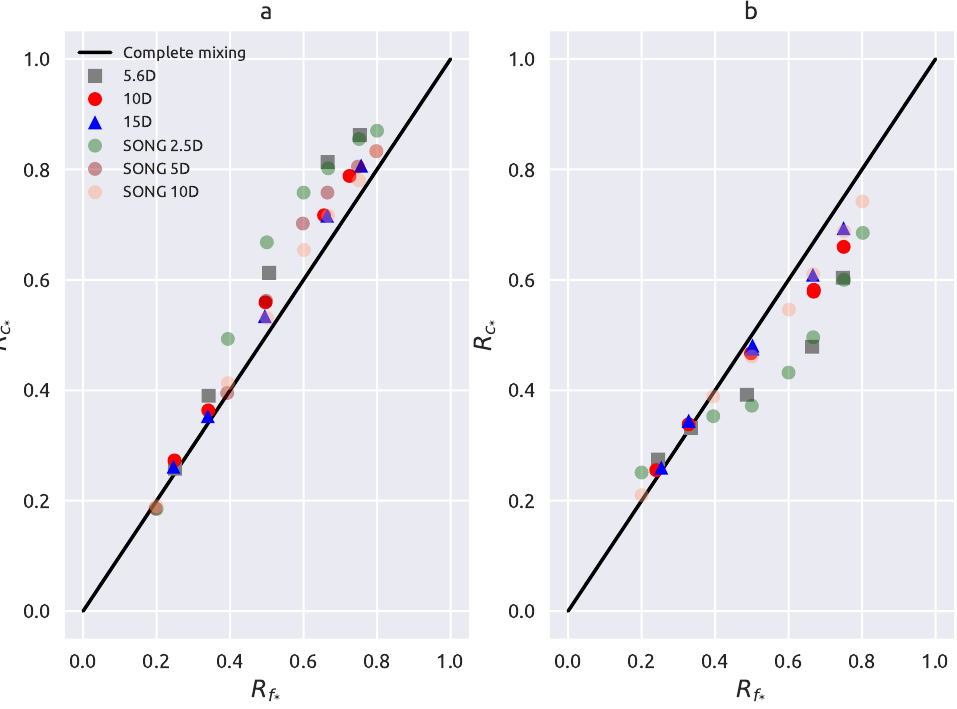
Figure 4. S and U configuration experimental results—normalized branch inlet conductivity ratio R c to normalized main pipe inlet flow R f compared with the previous study [16] and shown in relation to ∗ the complete mixing line: ( a ) Configuration S, ( b ) Configuration